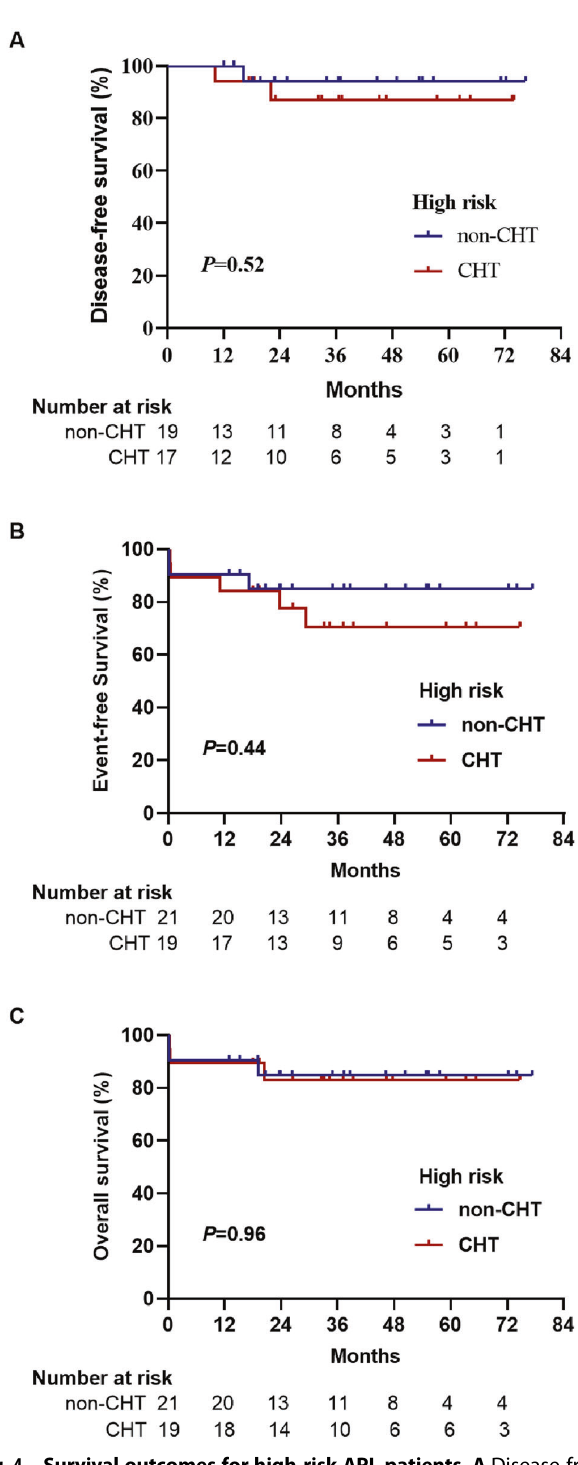
Fig. 4 Survival outcomes for high-risk APL patients. A Disease-free survival. B Event-free survival. C Overall